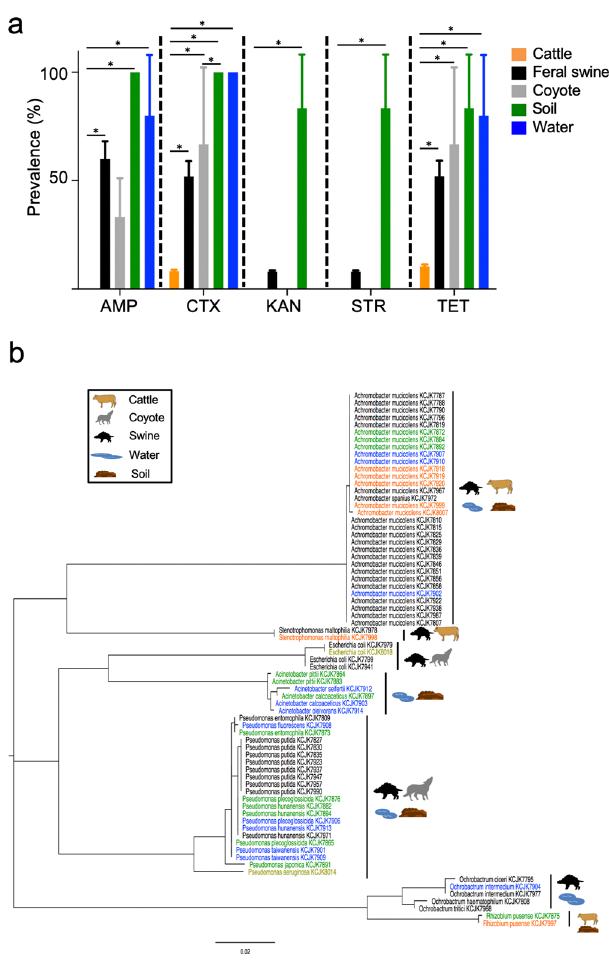
Fig. 2 Prevalence of antibiotic-resistant microorganisms (ARMs) at the wildlife-livestock interface. a The prevalence of ARMs by type of antibiotic (AMP ampicillin, CTX cefotaxime, KAN kanamycin, STR streptomycin, TET tetracycline). The error bars indicate 95% con fi dence intervals. The prevalence of ARMs among different antibiotics were also compared using a Chi-Square test as follows: cefotaxime vs. kanamycin in feral swine ( P < 0.0001), cefotaxime vs. streptomycin in feral swine ( P < 0.0001), tetracycline vs. kanamycin in feral swine ( P < 0.0001), tetracycline vs. streptomycin in feral swine ( P < 0.0001), cefotaxime vs. kanamycin in cattle ( P < 0.0001), cefotaxime vs. streptomycin in cattle ( P = 0.041), tetracycline vs. kanamycin in cattle ( P = 0.041), tetracycline vs. streptomycin in feral swine ( P = 0.021). Asterisks indicate a statistical difference ( P < 0.05) of each category comparison by Chi-Square test. b A phylogenetic tree of 16 S rRNA sequences from cefotaxime resistant bacteria estimated by maximum likelihood. Different colors indicate source of the isolate (black: feral swine, orange: cattle, olive: coyote, green: soil, blue: water).